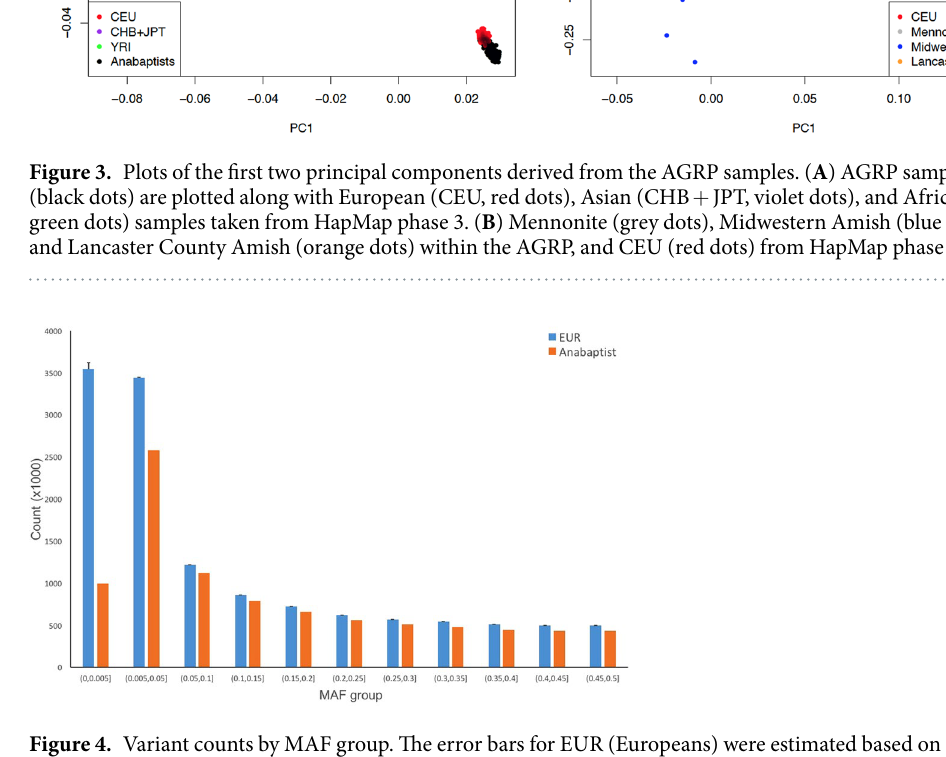
the 1000G. Total HBD length was significantly greater in AGRP than in 1000G ( P < 0.001; Fig. 6). Total HBD